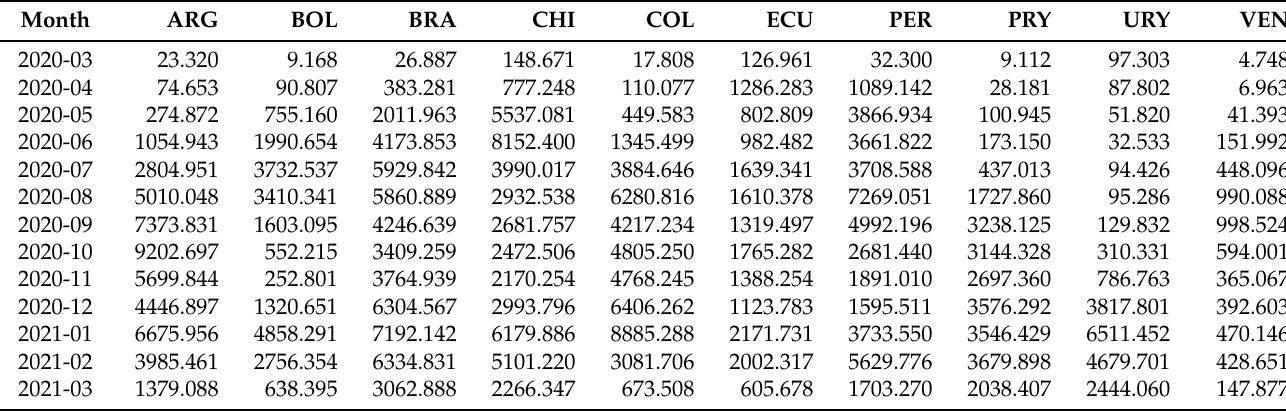
Table 1. Data matrix of the number of COVID-19 infected cases per million inhabitants for the indicated month and country.